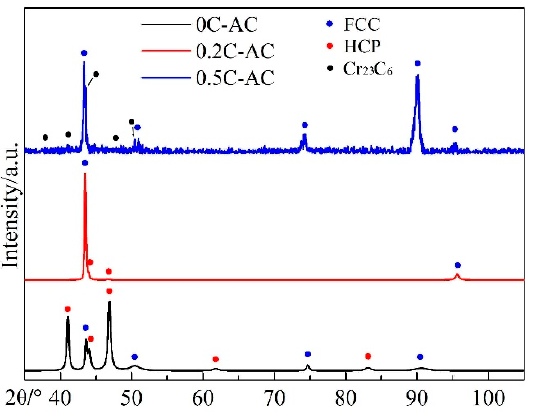
Figure 3. EDS diagram of the 0.5C-AC specimen. The table in the figure represents the mass fraction and atomic ratio of the test point, respectively. Figure 4. XRD patterns of the as-cast Fe50Mn30Co10Cr10 alloys with different carbon contents.